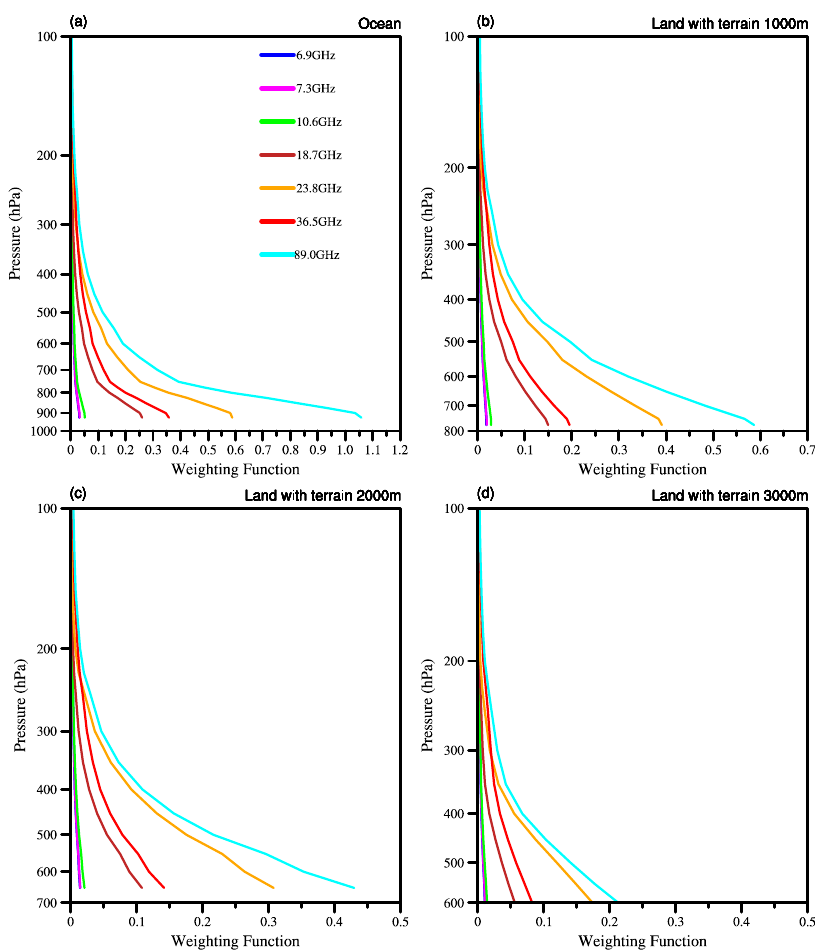
Figure 1. Weighting functions of the AMSR-2 channel 1–14 using CRTM based on the atmospheric profile over ocean ( a ) and for terrain height of 1000 m ( b ), 2000 m ( c ) and 3000 m ( d ) over land.